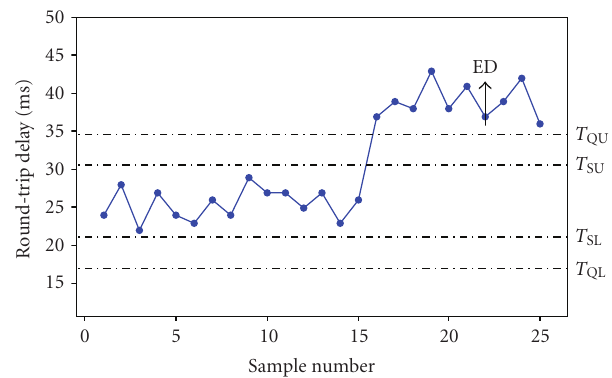
Figure 17: Plateau-detector thresholds